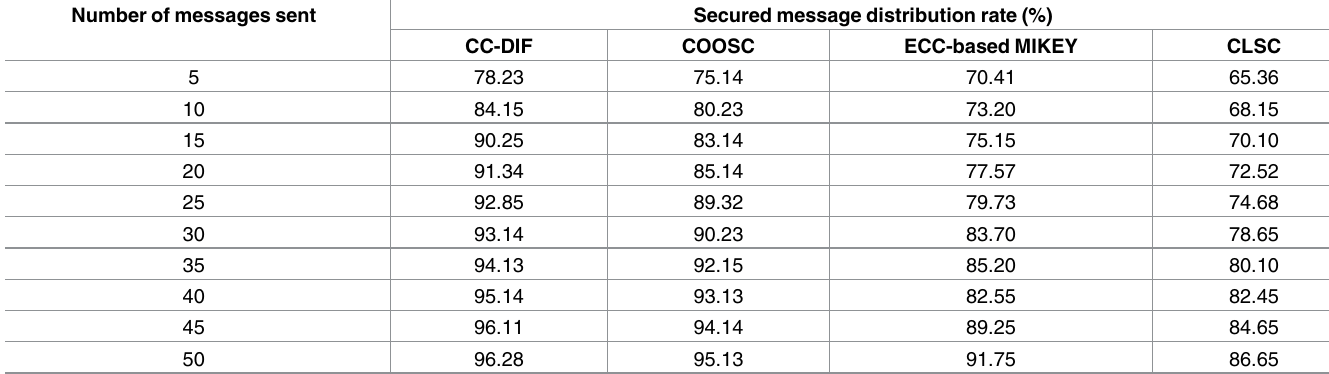
Table 5. Tabulation for secured messagedistributing